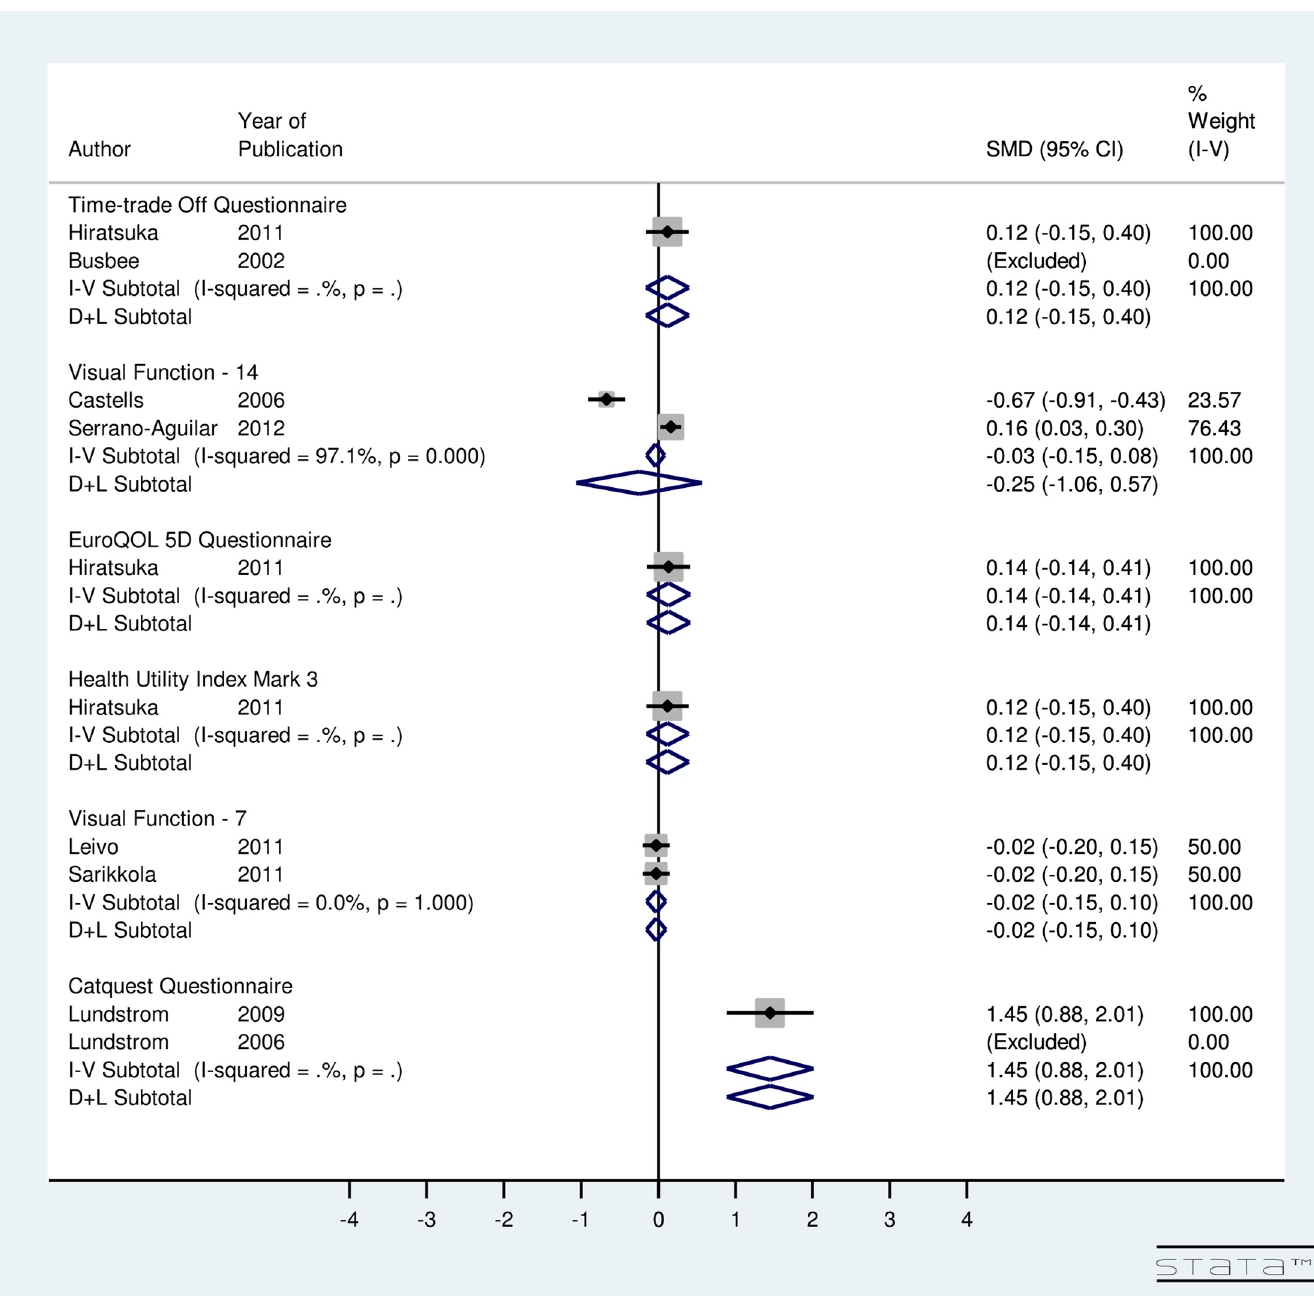
Fig 5. Forest Plot showing Improvement in Utility Due to Immediately Sequential Bilateral Cataract Surgery versus Delayed Sequential Bilateral Cataract